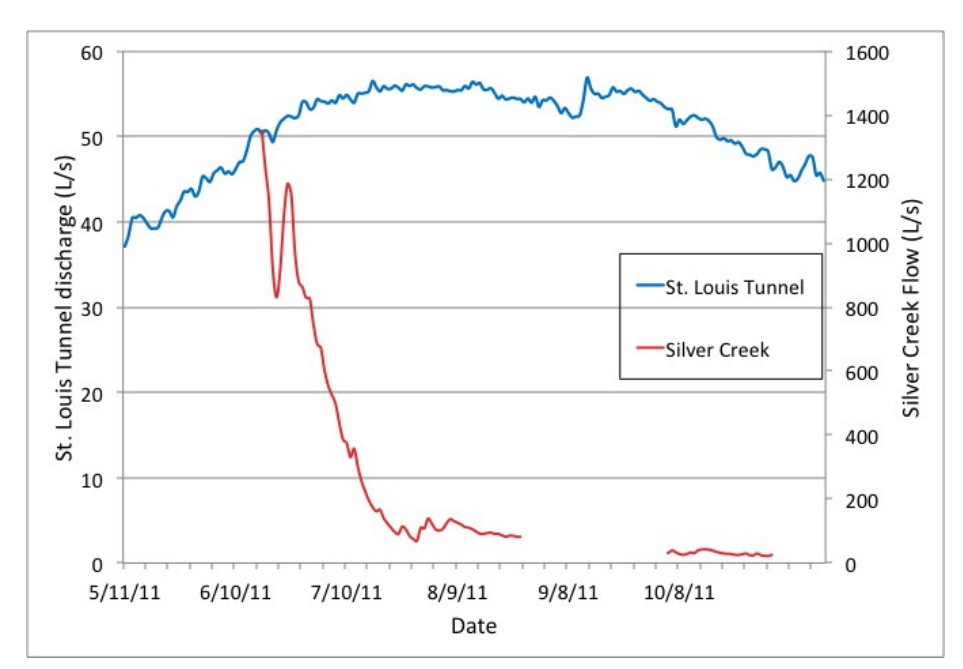
Figure 9. Mean daily discharge from the St. Louis Tunnel portal and from Silver